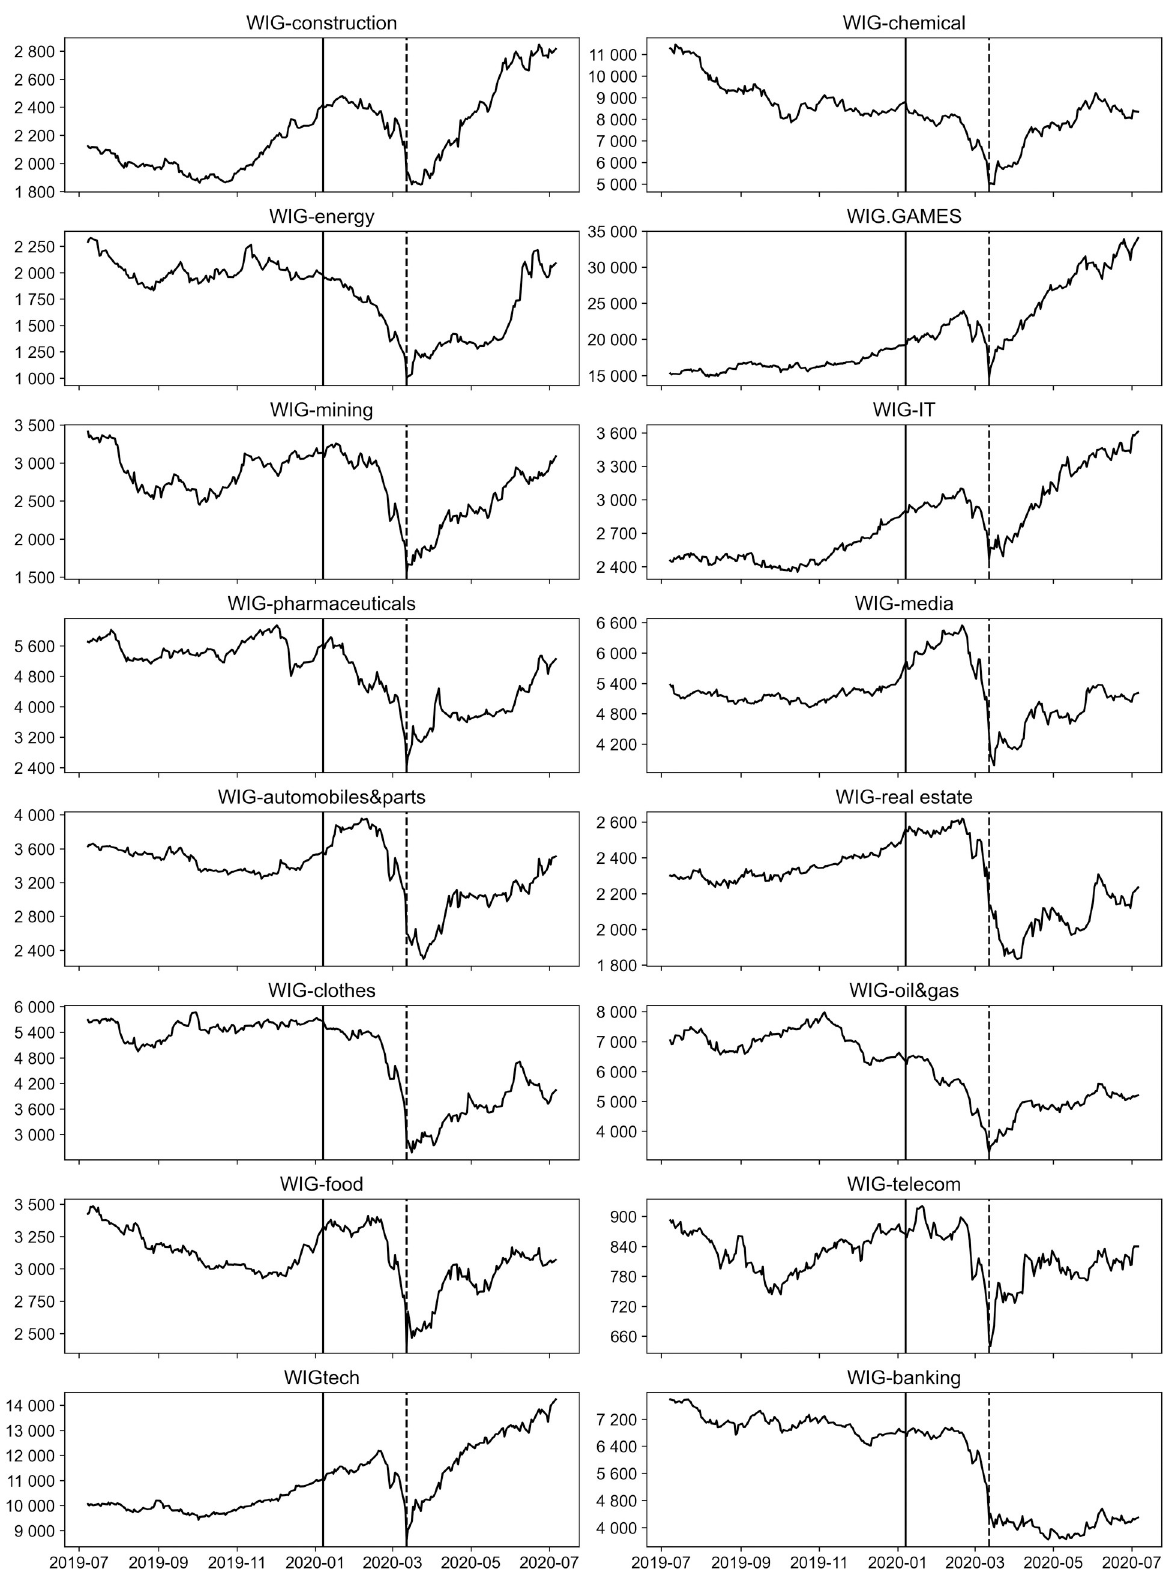
Fig 1. Dynamics of indices in the analyzed period. https://doi.org/10.1371/journal.pone.0250938.g001 PLOS ONE | https://doi.org/10.1371/journal.pone.0250938 May 20,